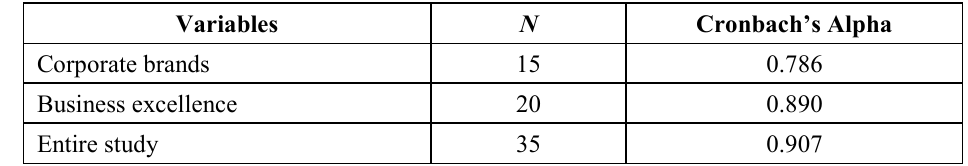
Table 2. The Results of the Reliability Test